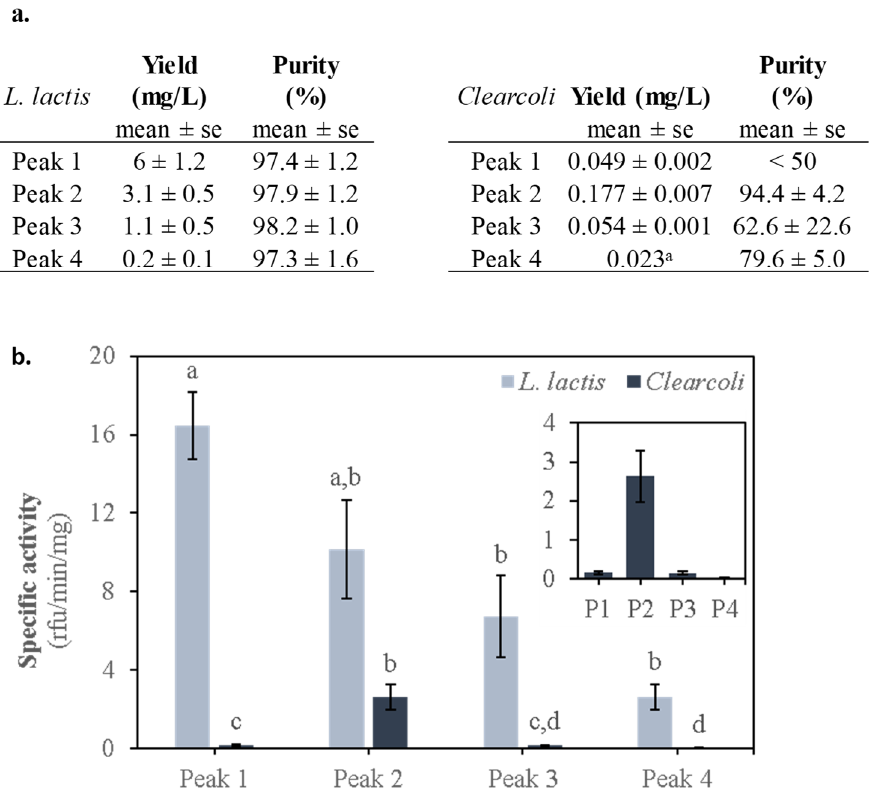
Figure 2. Table summarizing the yields for each peak, as mg of protein per peak per culture L (mg/L), and their purity in % for each expression system. a Peak 4 of Clearcoli was purified in enough amount to be quantified only once out of the 3 separate production experiments performed. Therefore, no SEM is shown ( a ). Specific activity for the MMP-9 in each peak solubilized from IBs produced by L. lactis and Clearcoli . Relative fluorescence units (rfu) refer to the fluorescence emitted by dye-quenched gelatin along its degradation kinetics due to MMP-9 activity. Specific activity is expressed as rfu per minute per MMP-9 mg (rfu/min/mg). Means and standard error of the mean (SEM) are depicted for each MMP-9 peak ( n = 4). Different letters (a to d) depict differences between protein peaks ( p = 0.002) ( b ).